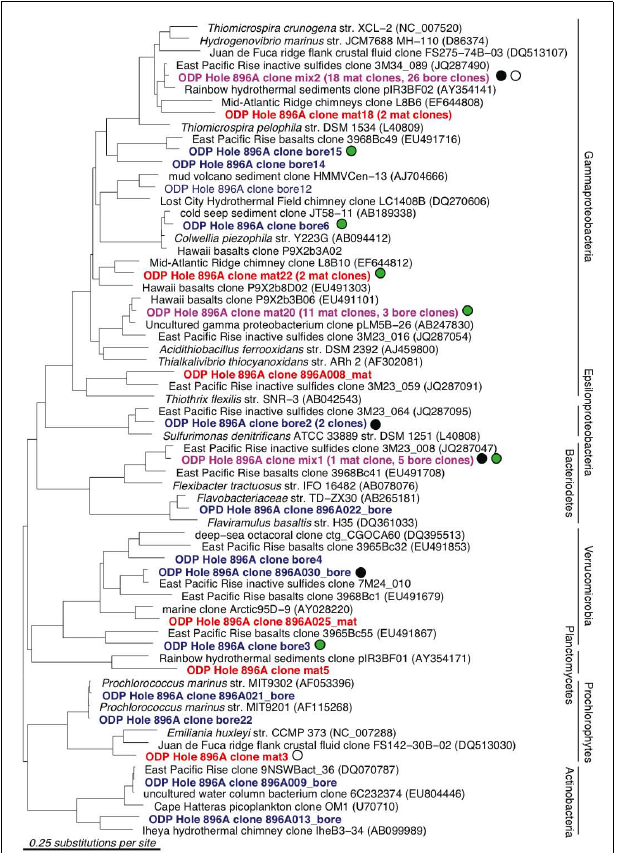
FIGURE 3 | 16S rRNA gene neighbor-joining phylogenetic tree for Hole 896A observatory bore and mat sample sequences in comparison to close relatives from the GenBank database, excluding theAlphaproteo- bacteria phylum. Clones from borehole fluids collected at the observatory spigot are labeled as bore in blue, and clones from the microbial mat on the exterior of the borehole are labeled as mat in red. Identical clones from both samples are labeled in purple. Short sequences are indicated with asterisks. Sequences that are shared with other clone libraries are indicated with colored dots: East Pacific Rise inactive massive sulfides (black); East Pacific Rise and Loihi Seamount basalts (green); Juan de Fuca Ridge flank crustal fluids (white); Juan de Fuca CORK Hole 1301A (yellow).